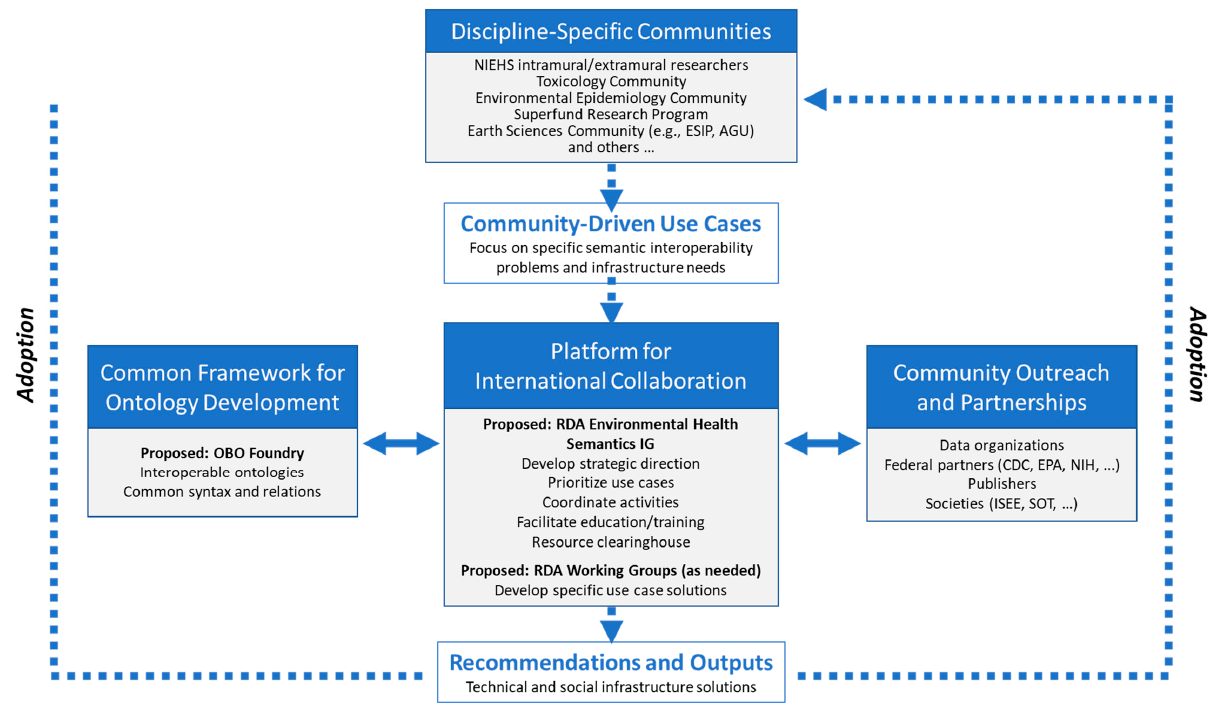
Figure 2. Proposed community model.